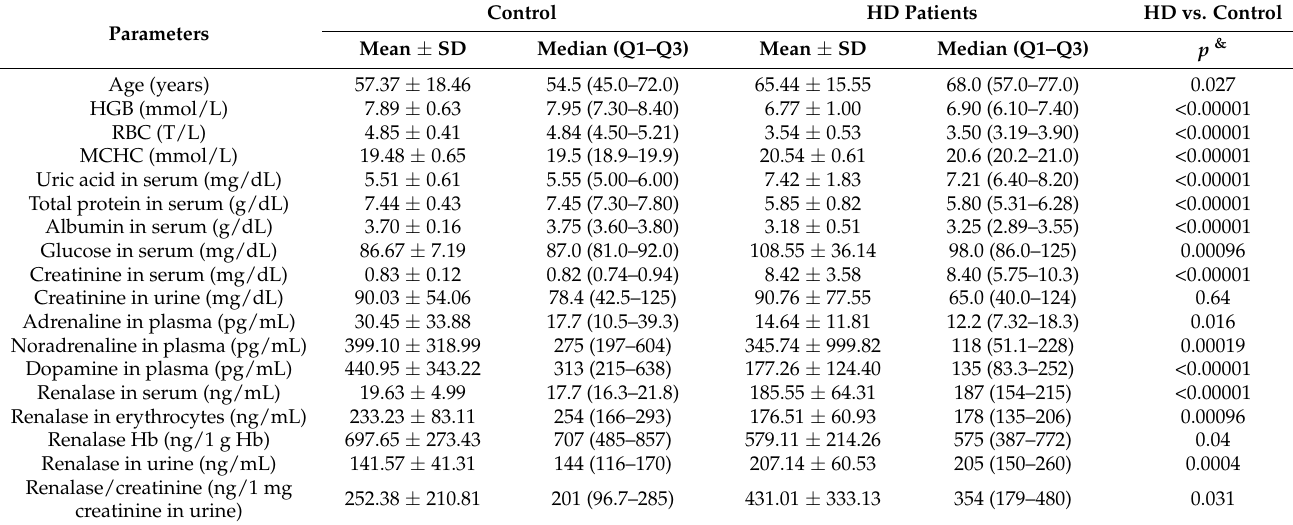
Table 1. Comparison of studied parameters between hemodialysis patients and control subjects. Control HD Parameters